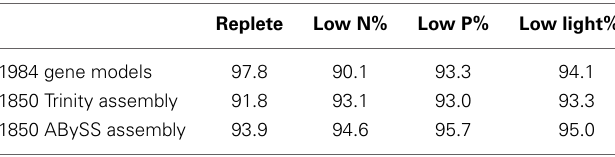
Table 2 | The percentage of trimmed reads that mapped to the CCMP 1984 gene models and the two CCMP 1850 de novo assemblies.